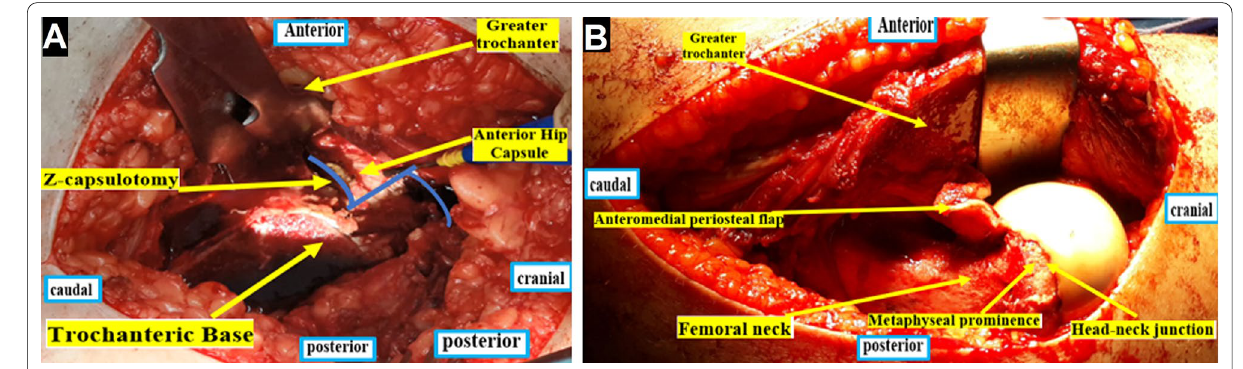
Fig. 4 A Z‑shaped capsulotomy. B Development of the periosteal‑retinacular flap